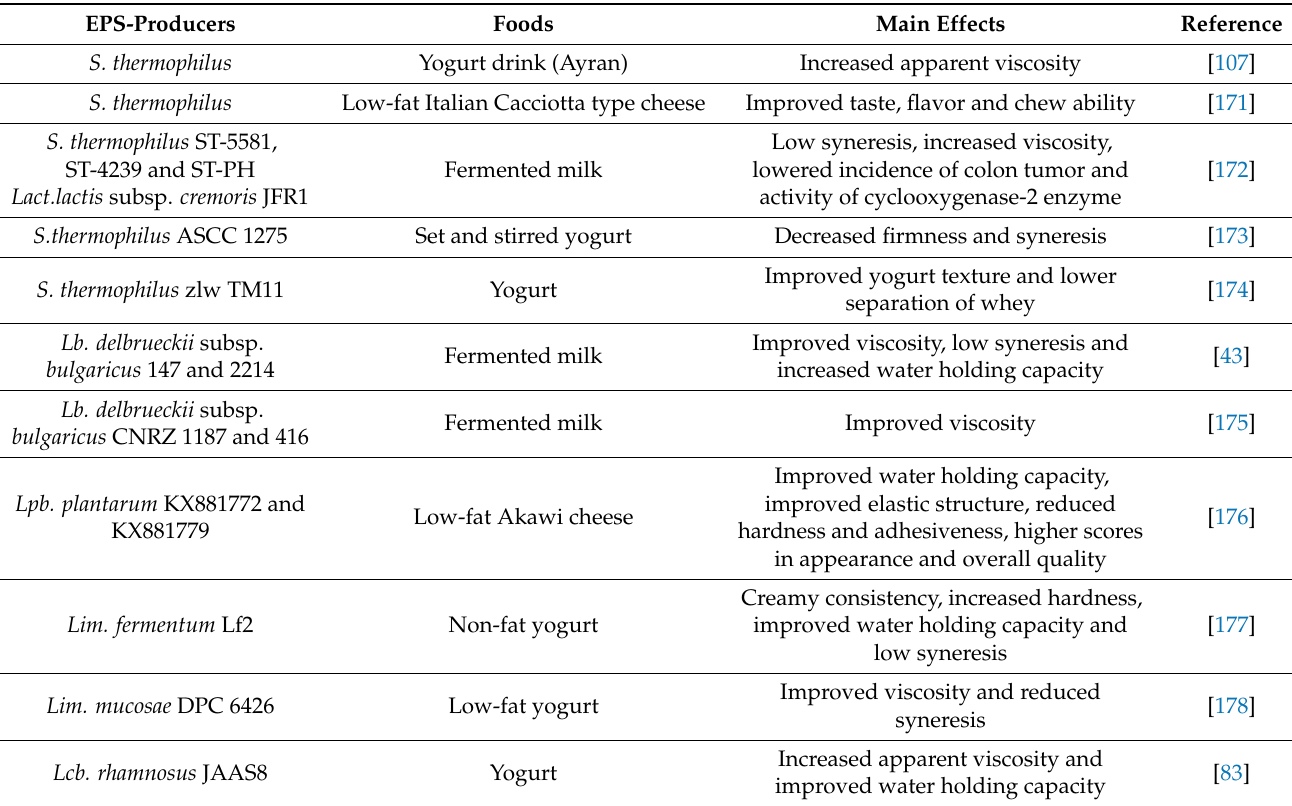
Table 4. EPS-producing strains in fermented milk products and their effects on techno-functional properties. EPS-Producers Foods Main Effects